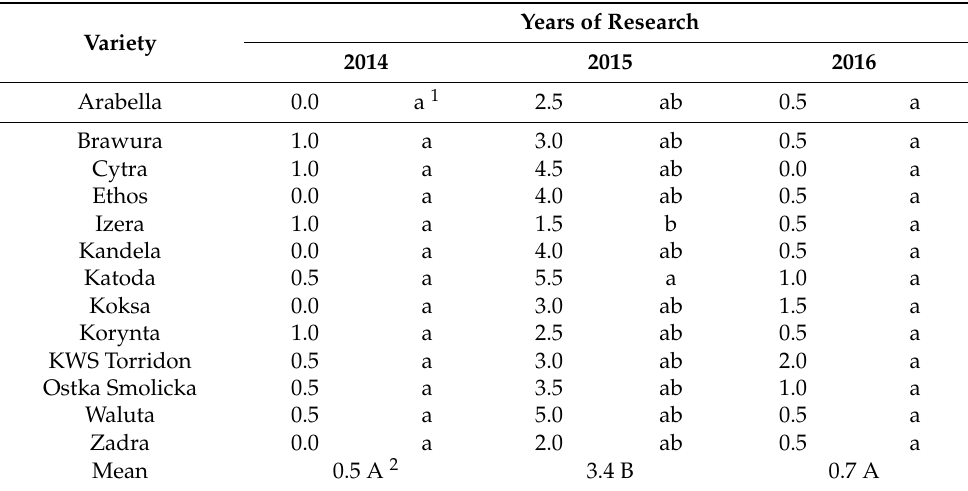
Table 3. The occurrence of FHB on the ears of spring wheat varieties (% of ears infested by Fusar- ium